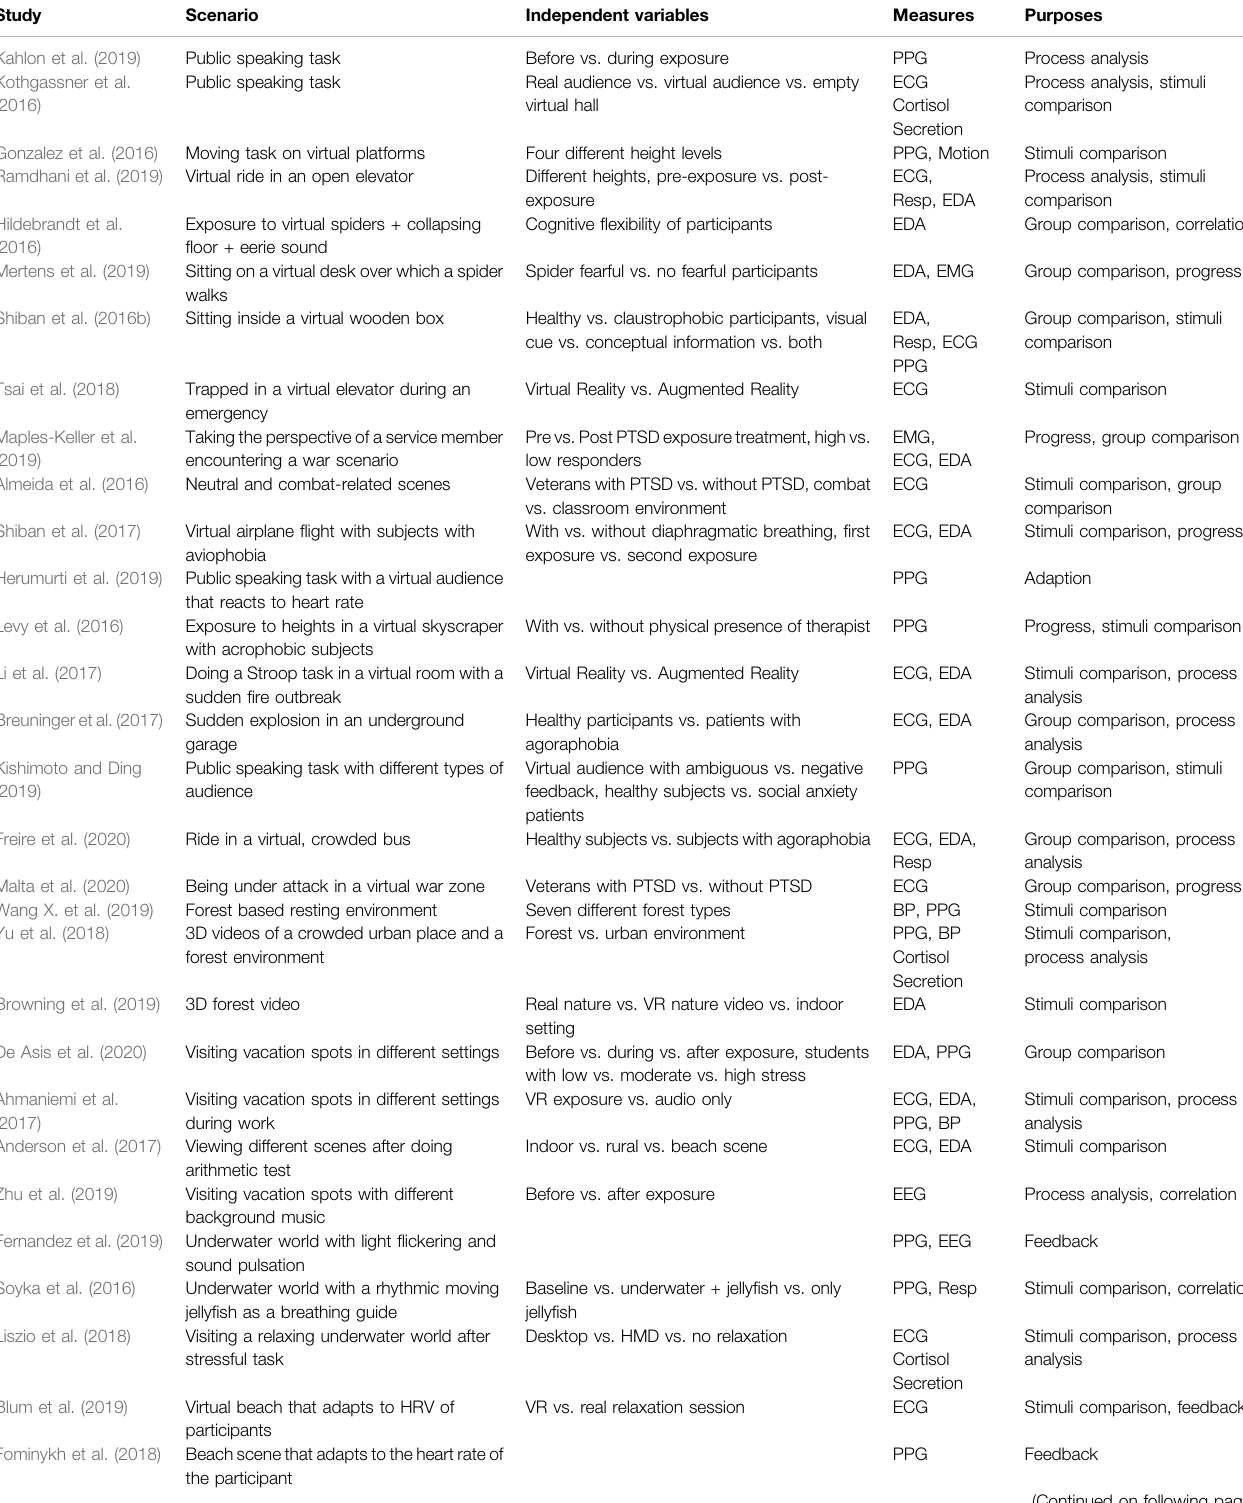
TABLE5| Overviewoftheworksfromthe fi eldoftherapyandrehabilitationthatwerediscussedin Section4.1.1 .TheMeasurescolumnreferstothephysiologicalmeasures usedinthework.TheentriesoftheIndependentVariablescolumnoftendonotcovereverythingthatwasconsideredinthework.EntriesinthePurposescolumnreferto the categories listed in Section 4.1.6